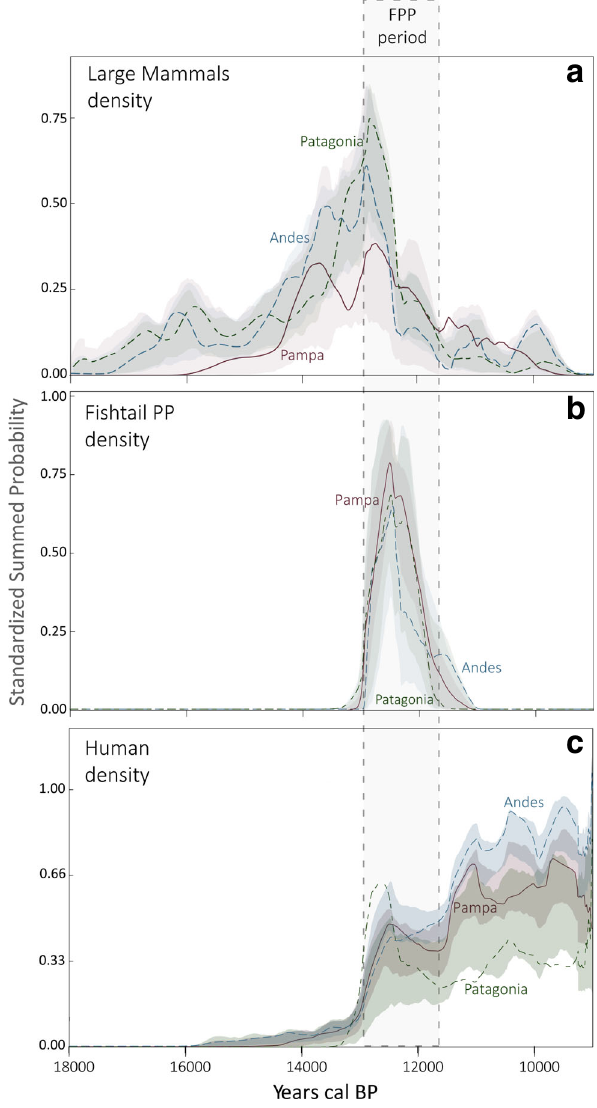
Fig. 2 Regional differences in summed probability distribution curves within South America. The temporal change in the density of large mammals ( a ), Fishtail projectile points ( b ), and all archeological sites ( c ) described using SCPD curves. Different regions are indicated in shading colors: Andes (light blues), Pampa (light red), Patagonia (light green). X axis represents Calibrated years BP and Y axis the standardized summed